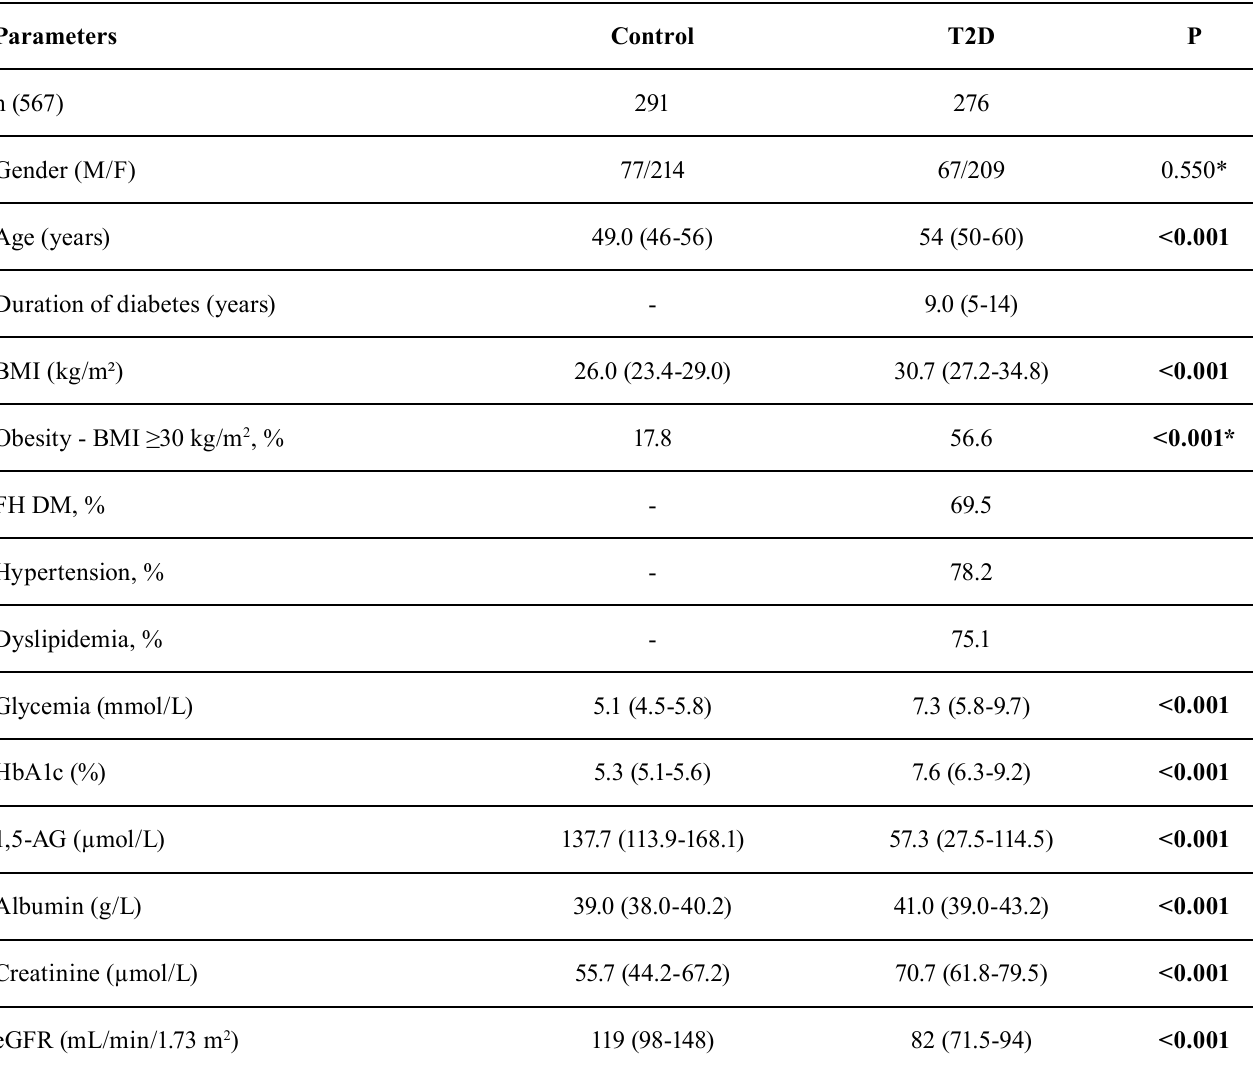
TABLE 1 – Anthropometric, clinical and laboratory characteristics of the studied groups